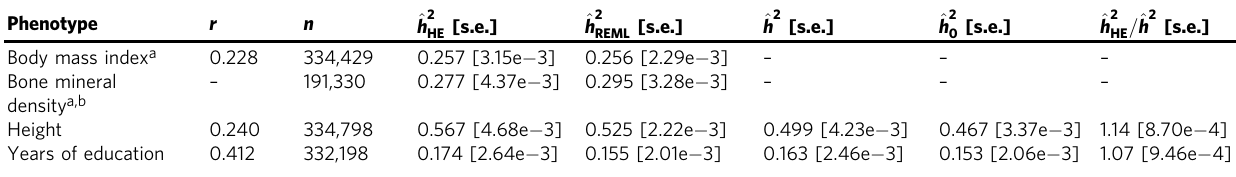
Table 1 In fl ation of heritability estimates and their corrected values for select UK Biobank